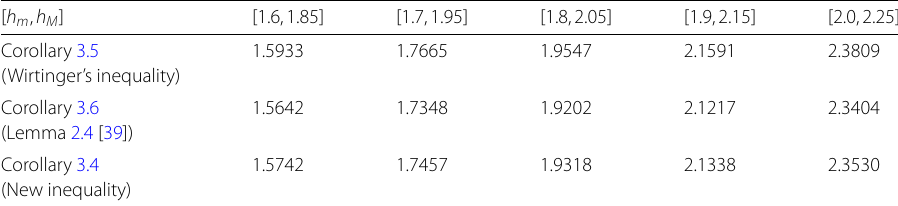
Table 7 MALBs of c 2 for T = 30, (cid:9) = 0.45 and different values of [ h m , h M ] ( h Mm = 0.25) in Example 4.2 (Case III)